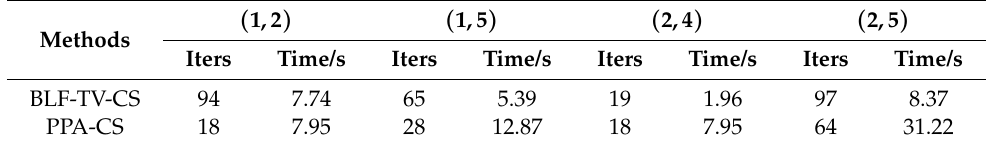
Table 4. Iterations and CPU time (in seconds) of the BLF–TV–CS method and our proposed PPA-=CS method for the original images shown in Figure 2a ( 1,2 ) , ( 1,5 ) , ( 2,4 ) and ( 2,5 ) .